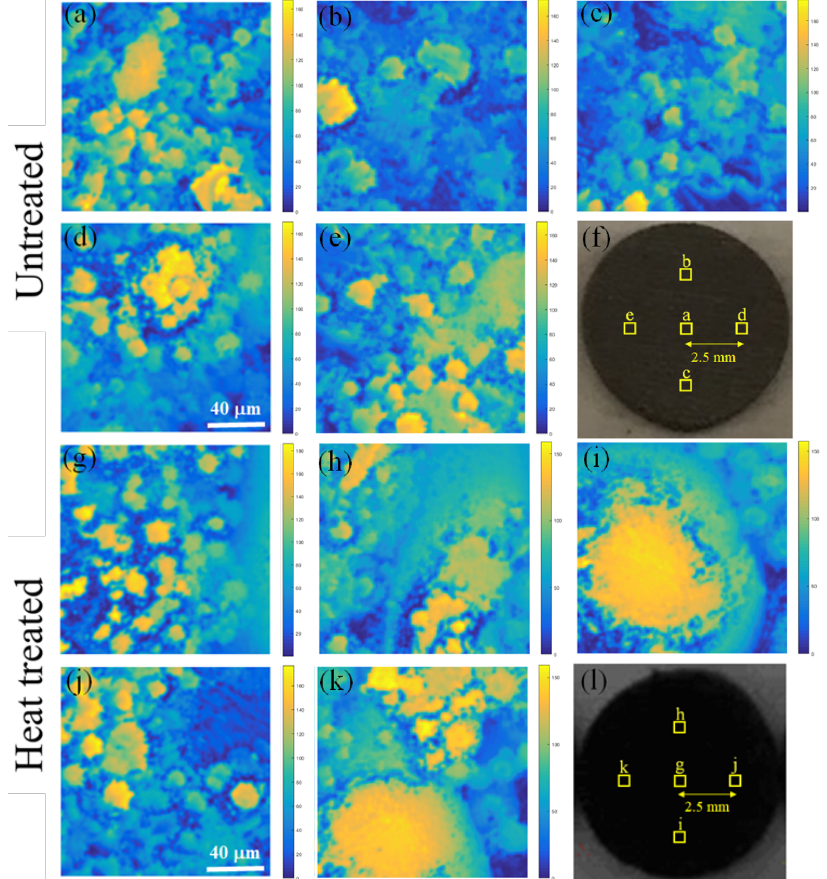
Figure 3. 3D surface topographies of Ti64 specimens measured using a laser confocal 3D profiler. Figure 3. ( a – e )/( g – k ) Surface heights of untreated/heat-treated Ti64 specimens; ( f , l ) untreated and